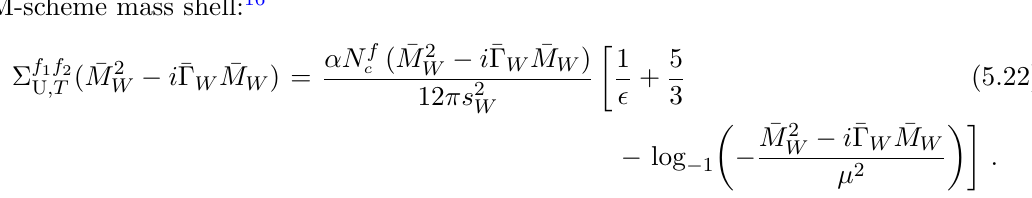
(see eq. (5.27)), U ;T